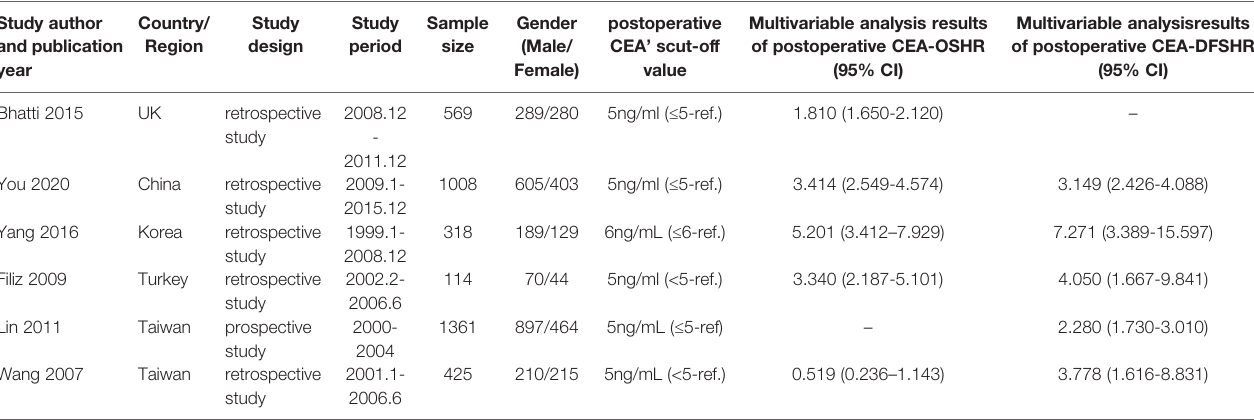
TABLE 5 | Baseline characteristics of meta-analysis